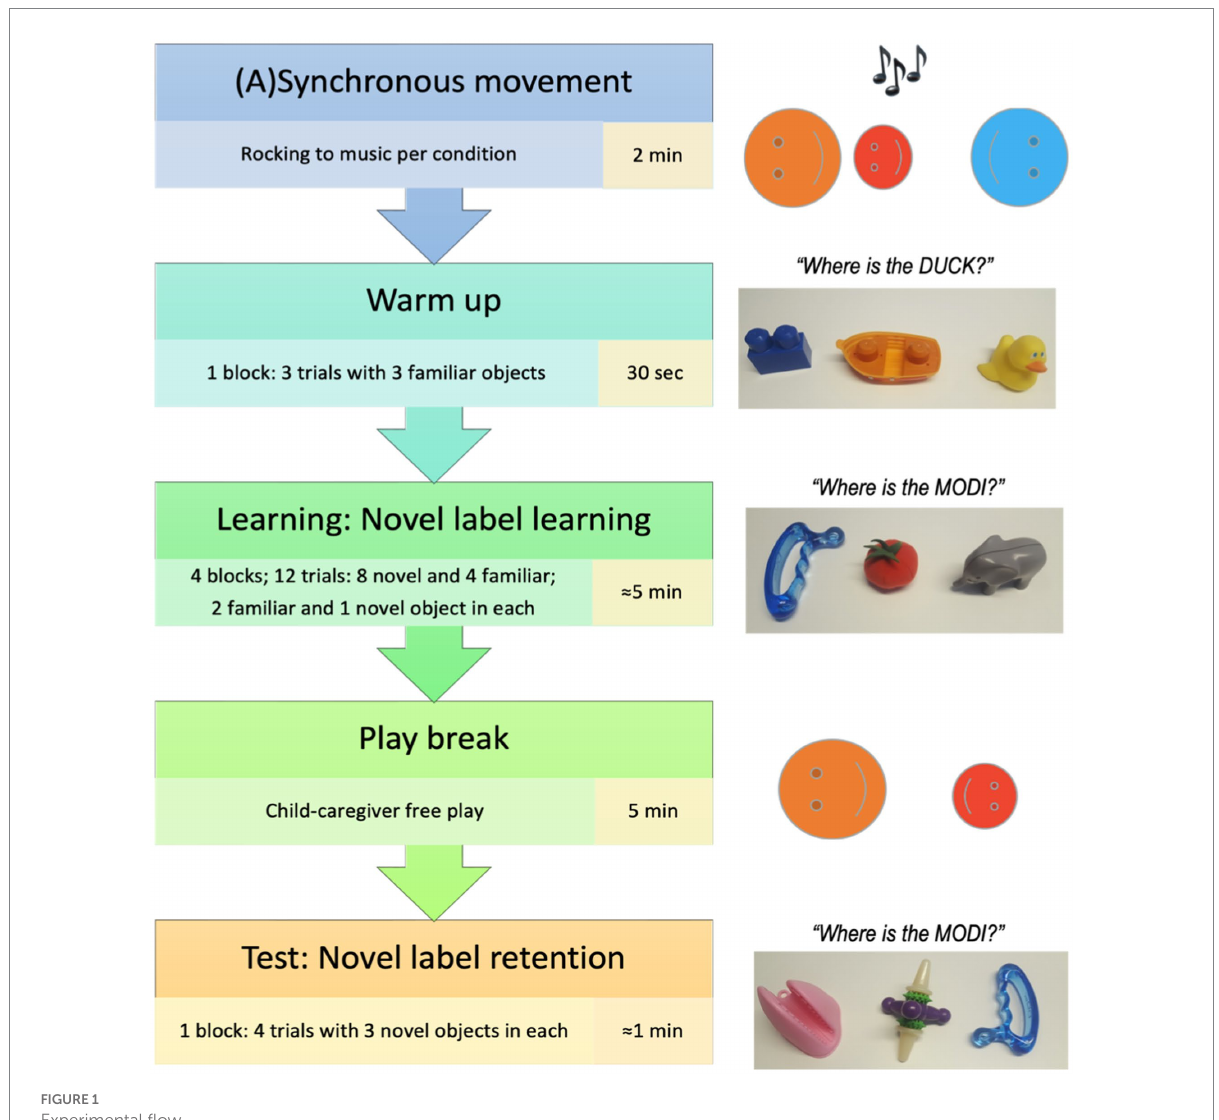
FIGURE 1 Experimental